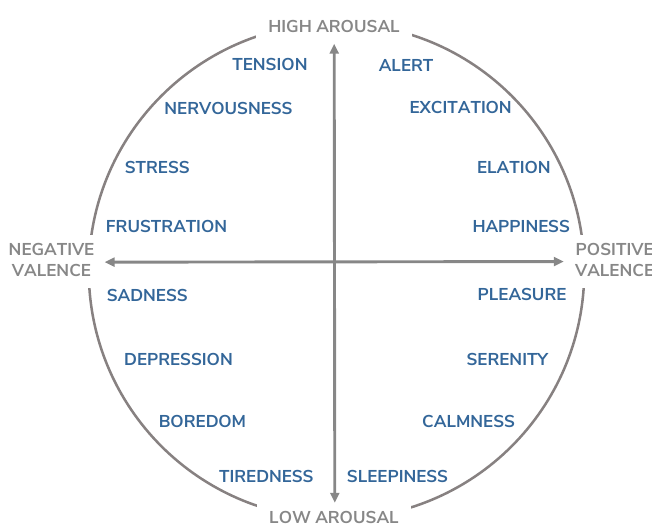
Figure 3. Russell’s circumplex model of mood